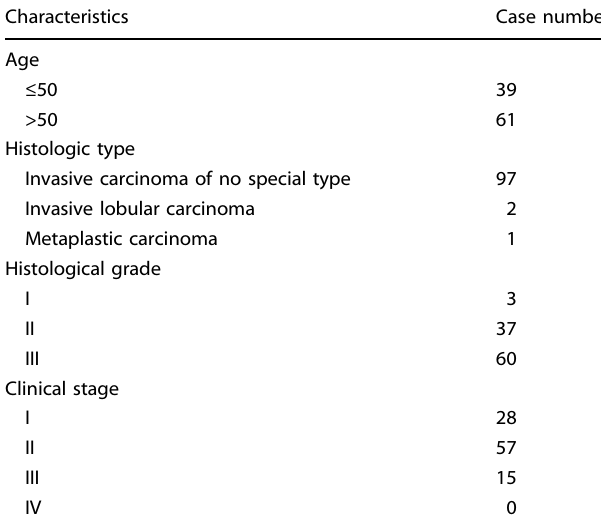
Table 1. Patient characteristics of 100 cases of invasive breast